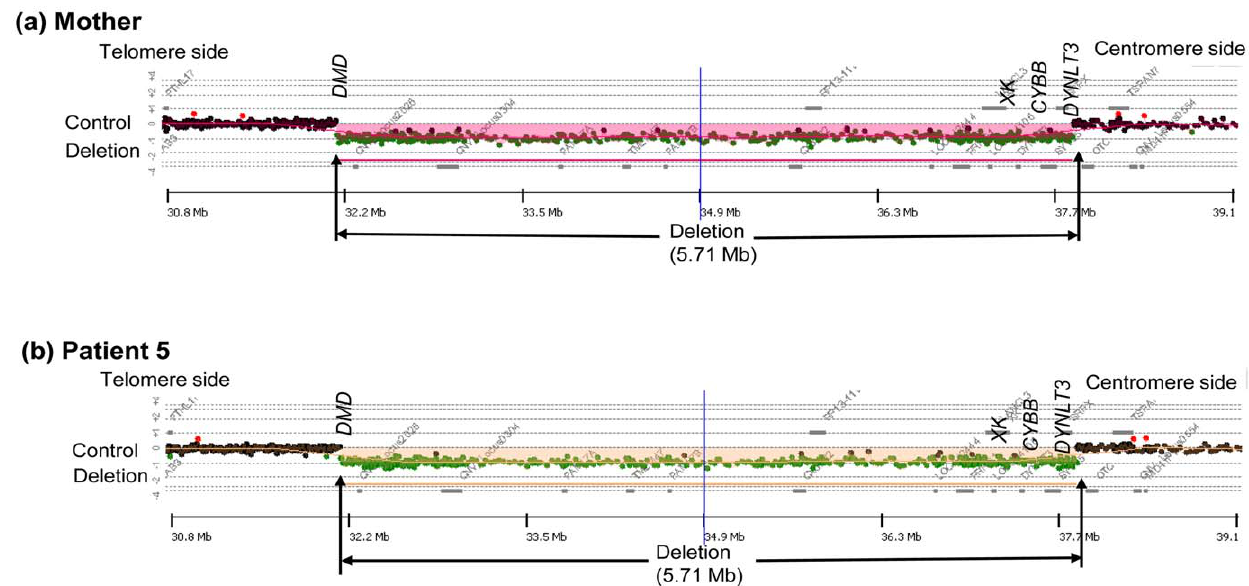
Figure 5. The Results of aCGH Analysis Spanning the Deletion Breakpoints in Mother and Patient 5. A female’s DNA was used for the control DNA. This case involved deletions of four genes, the chronic granulomatous disease gene ( CYBB ), the Duchenne muscular dystrophy gene ( DMD ), the McLeod syndrome gene ( XK ), and DYNLT3 . The gene deletion region was about 5.71 Mb and encompassed an area from CYBB to the greater part of the DMD (b). A similar gene deletion was also observed in the mother (a).